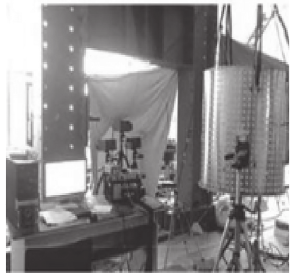
Figure 6: Experimental